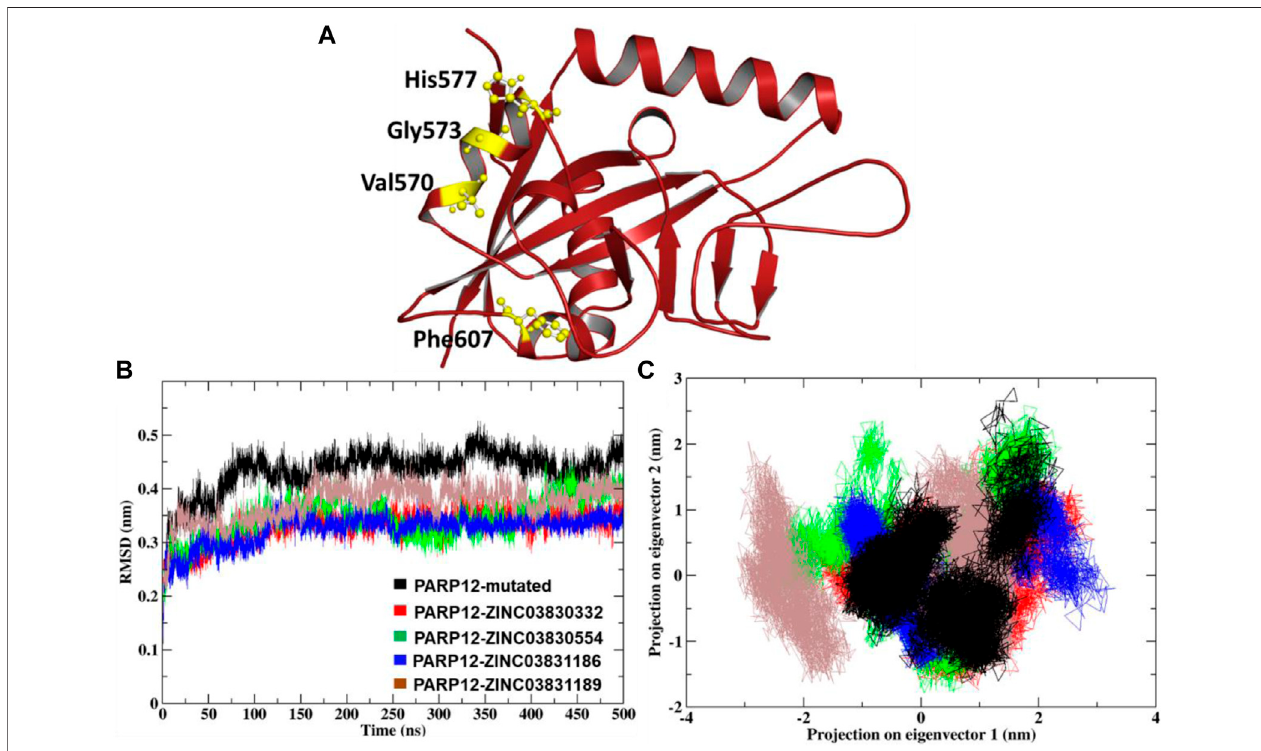
FIGURE3|(A) MutationinducedbyPARP12structures, (B) comparisonoftheRMSDplot,and (C) dynamicmotionofprojectionintheeigenvector1vs.2andthe plot two generated for the MD complexes showing conformational space of C α -atoms.